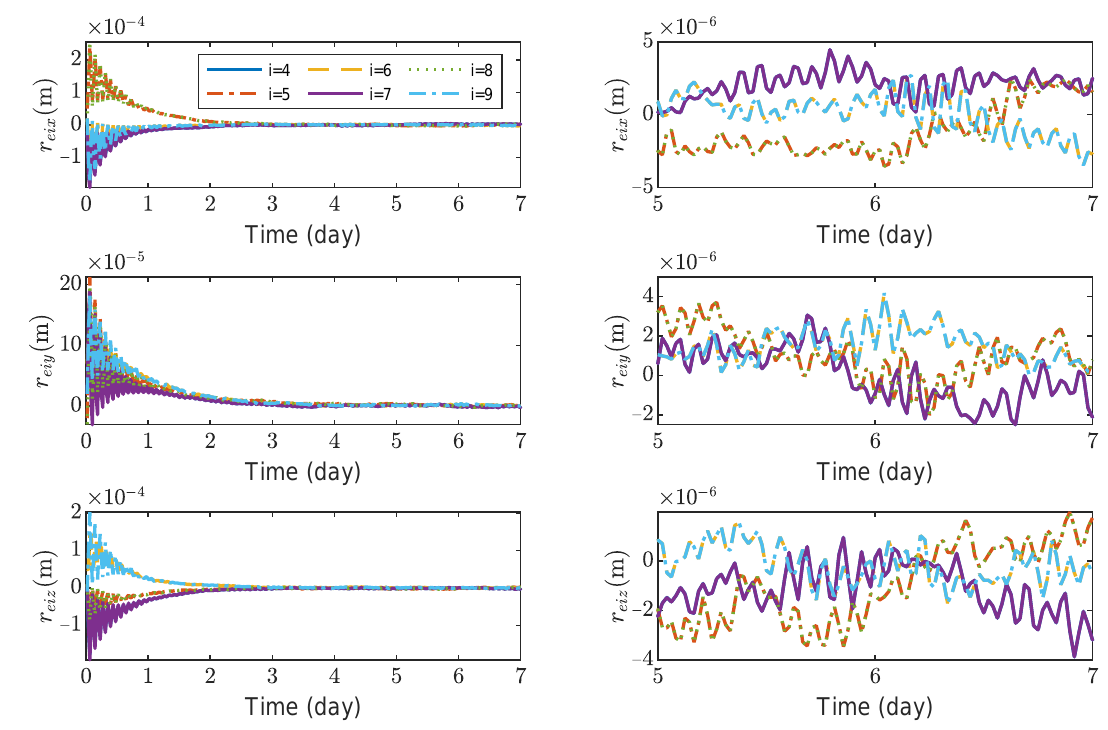
Figure 8. Relative position errors of TM1 ∼ 6, the max control force of test mass is 0.2 µ N.